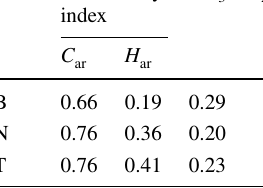
Table 3 Molecular indexes of organic matter of coals based on the FTIR spectra